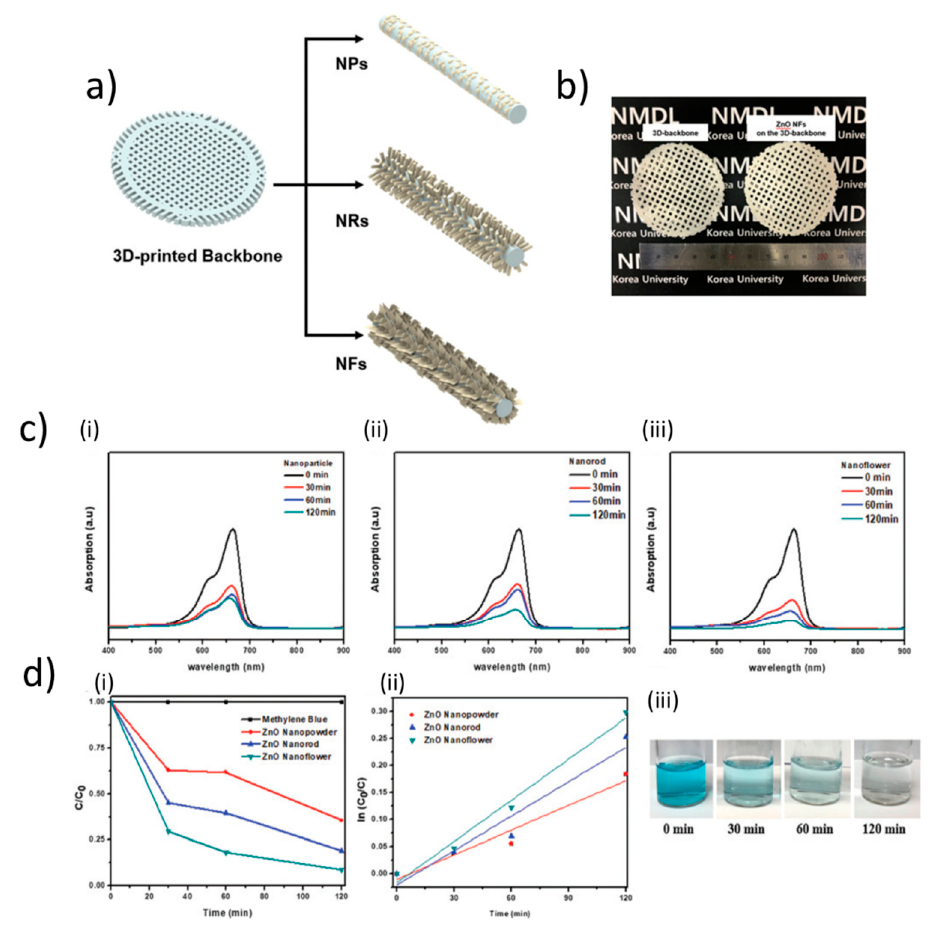
Figure 12. Applications in photocatalysis. ( a ) Schematic representation of ZnO nanoparticles (NPs), nanorods (NRs), and nanoflowers (NFs) on the 3D backbone and ( b ) images of the 3D backbone (ABS + ZnO) and ZnO-NFs hierarchical structure on the 3D-backbone. Degradation of methylene blue (MB) dye solution. ( c ) Ultraviolet–visible (UV–Vis) absorption of MB photodegraded by ZnO (i) NPs, (ii) NRs, and (iii) NFs on 3D-backbones. ( d ) Graphs showing the (i) kinetics of methylene blue degradation and (ii) pseudo-first order rate constants of time. The photographs in (iii) show the MB degradation by ZnO-NFs on the 3D backbone. Reproduced with permission from the Royal Society of Chemistry, from Reference [107]; permission conveyed through Copyright Clearance Center, Inc.